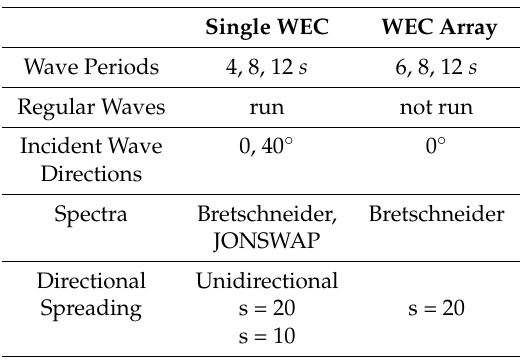
Table 3. Summary of wave conditions run for individual WEC and WEC array cases.